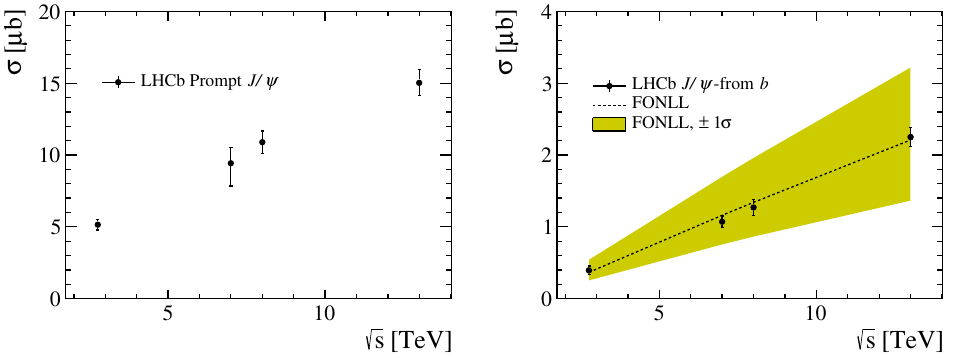
Figure 10 . The J= production cross-section for (left) prompt J= and (right) J= -from- b mesons as a function of pp collision energy in the LHCb (cid:12)ducial region compared to the FONLL calculation. In general, the correlated and uncorrelated systematic uncertainties among di(cid:11)erent measurements are of comparable magnitude.